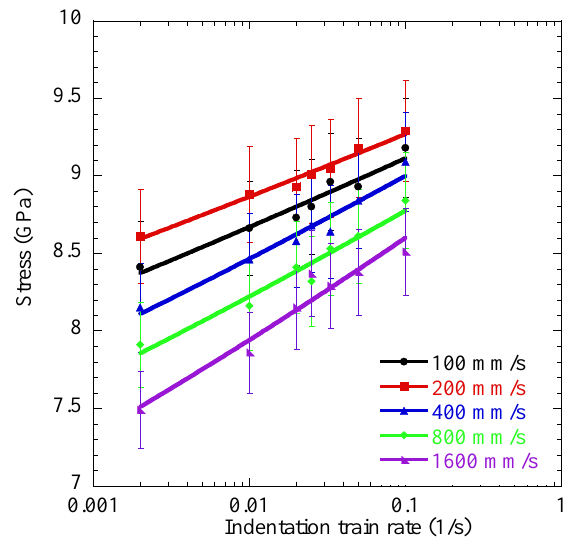
Figure 4. Representative stress as a function of strain rate.